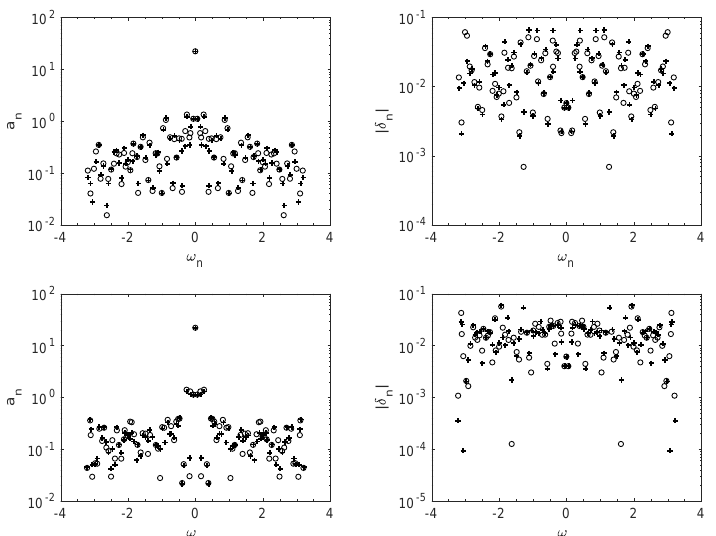
Figure 7. Frequencies vs. amplitudes ( left ) and growth rates ( right ) in the HODMD analysis for the data collected in the left ( top ) and right ( bottom ) sides. Crosses and circles represent the analysis carried out retaining N = 4 and N = 5 singular values, respectively.